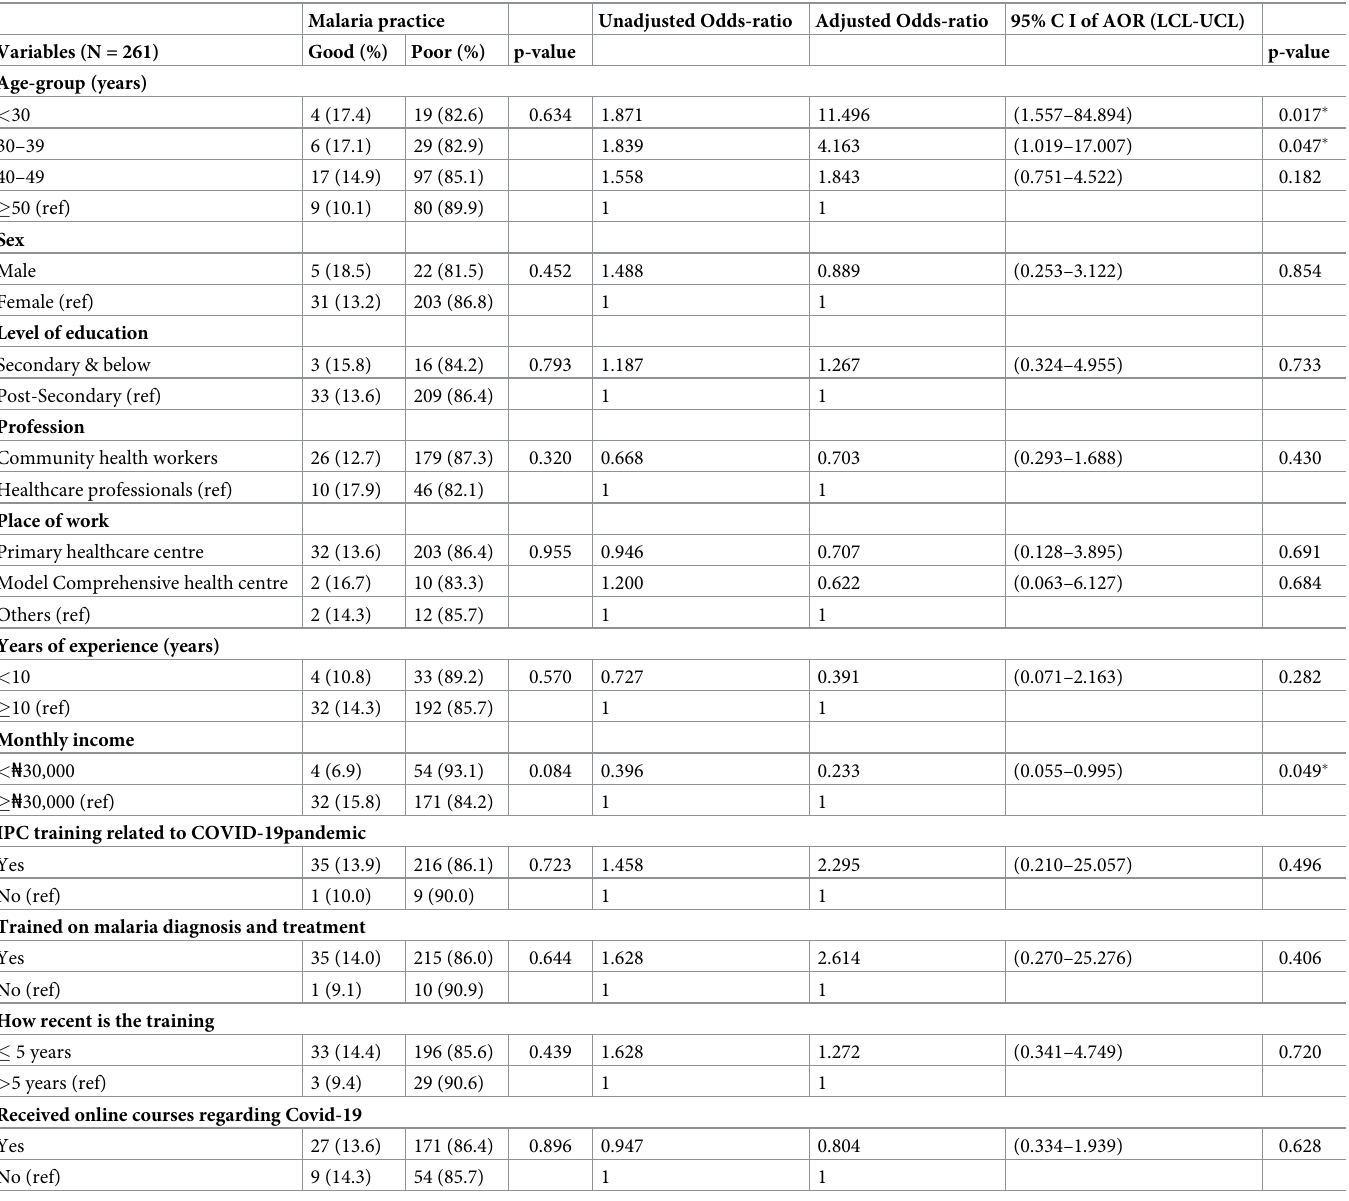
Table 4. Factors influencing malaria practice of healthcare